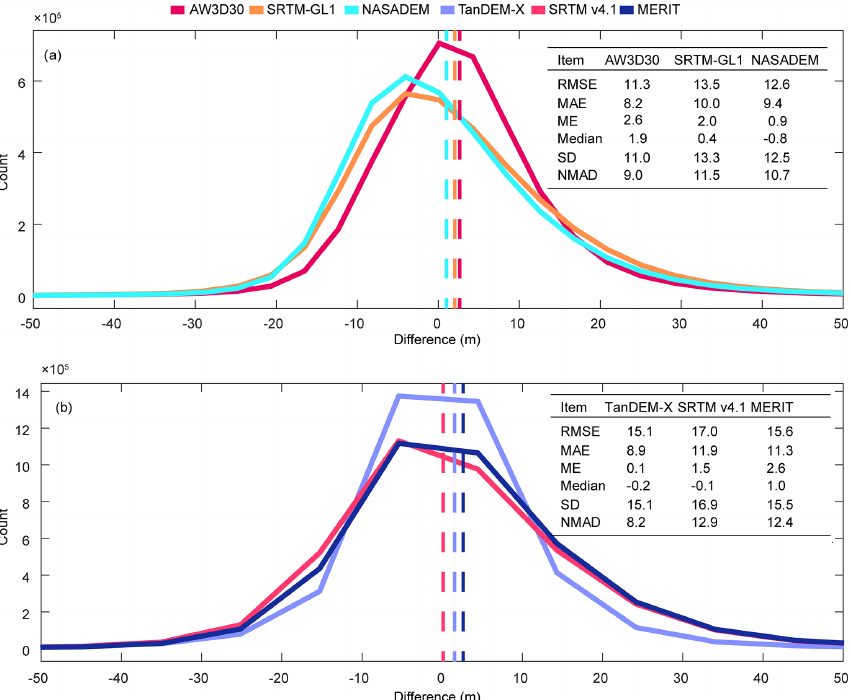
Figure 4. Overall difference (m) statistics between six DEMs and ICESat-2 elevation: (a) 30m resolution DEMs – AW3D30, SRTM-GL1, and NASADEM – and (b) 90m resolution DEMs – TanDEM-X, SRTM v4.1, and MERIT. The vertical dashed lines denote the mean elevation difference of each DEM between ICESat-2. ME is mean error; MAE is mean absolute error; median is median error; RMSE is root mean square error; SD is standard deviation; and NMAD is normalized median absolute